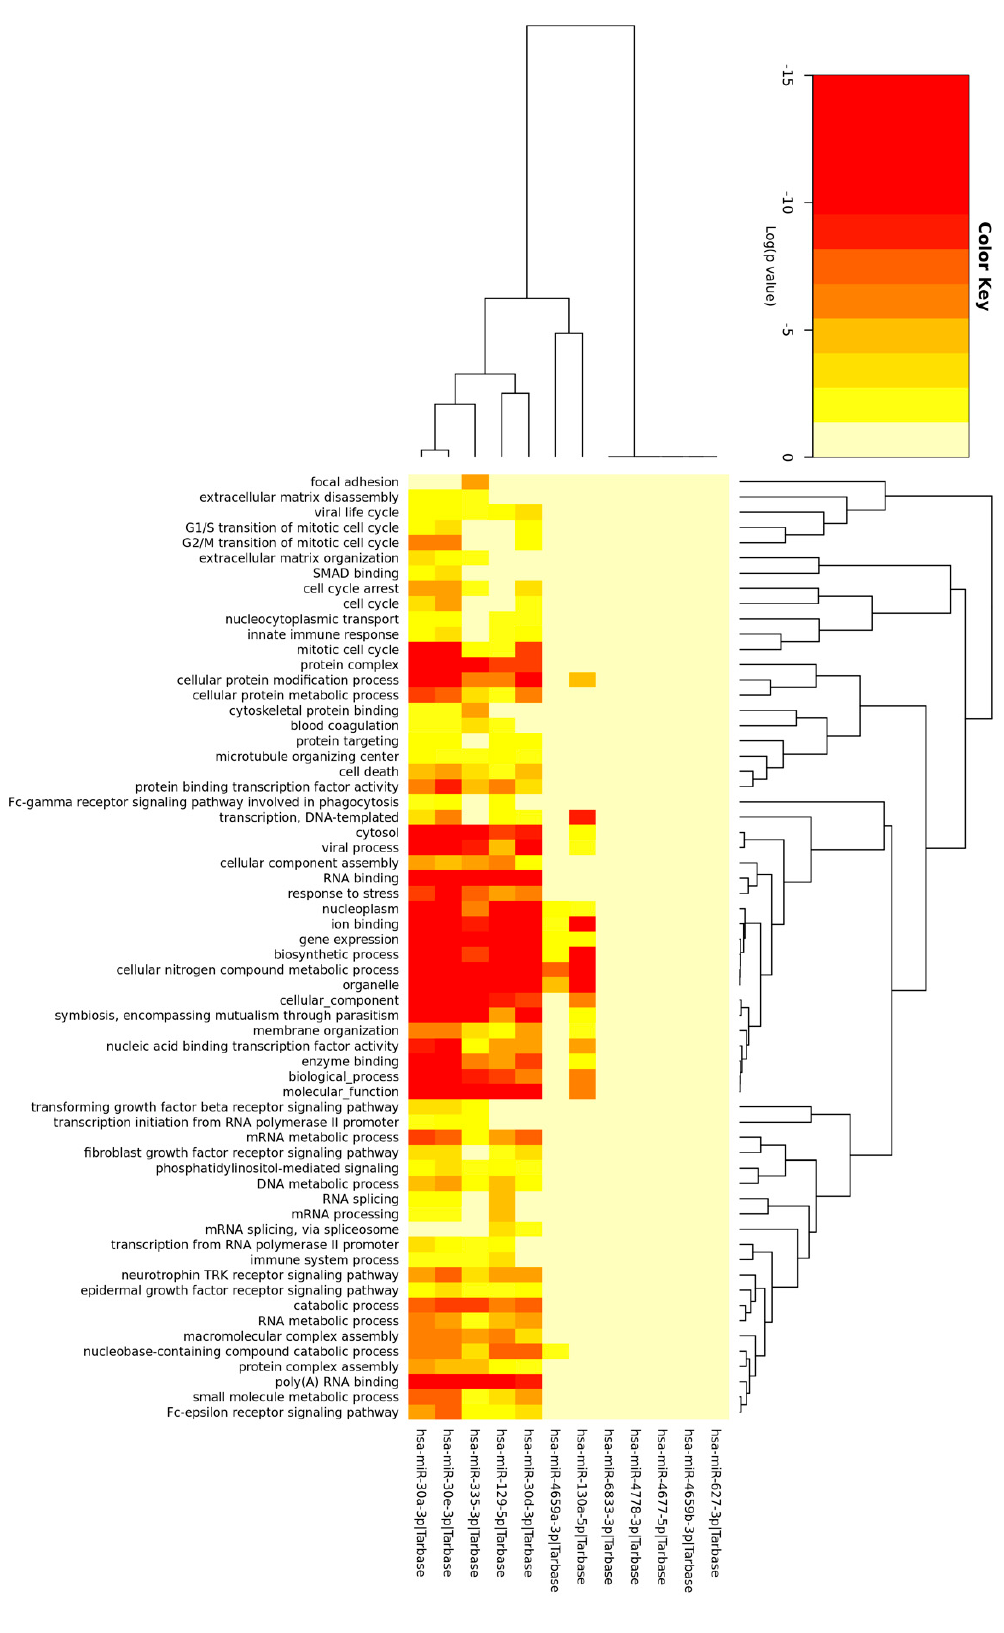
Figure 1. Heatmap of GO terms of the mRNA targets of 12 miRNAs. Heatmap showing which GO terms are associated with each miRNA and the colors associated with the p value for the miRNA/GO term pair.